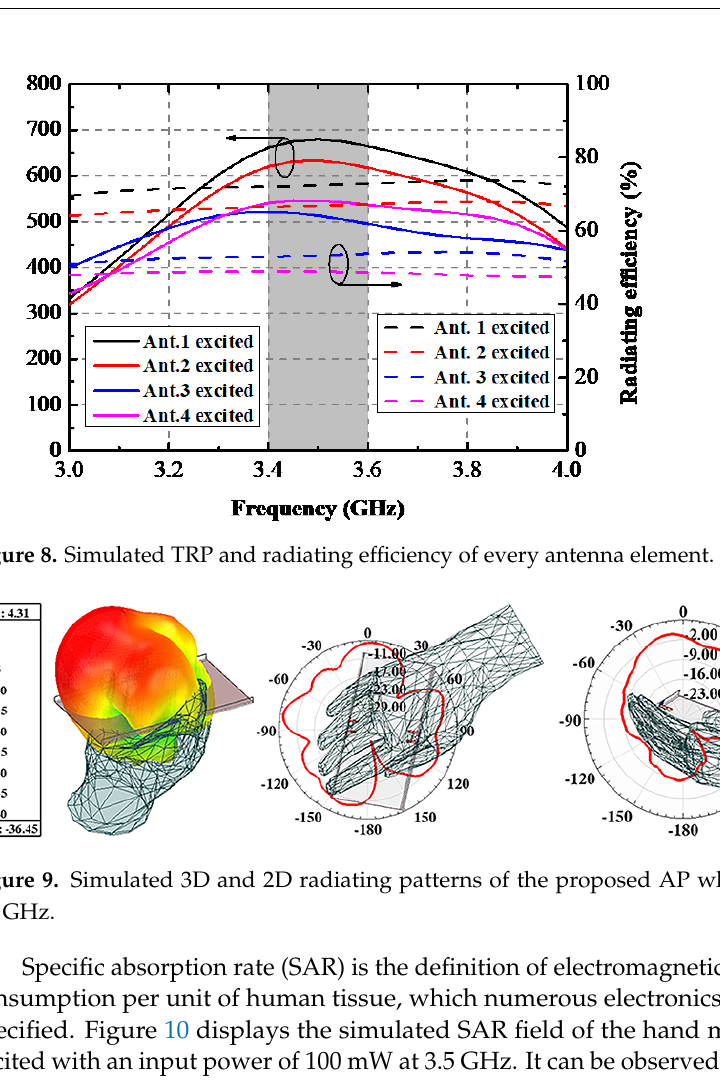
Figure 7. Simulated S-Parameters when this AP system is in SHM mode.